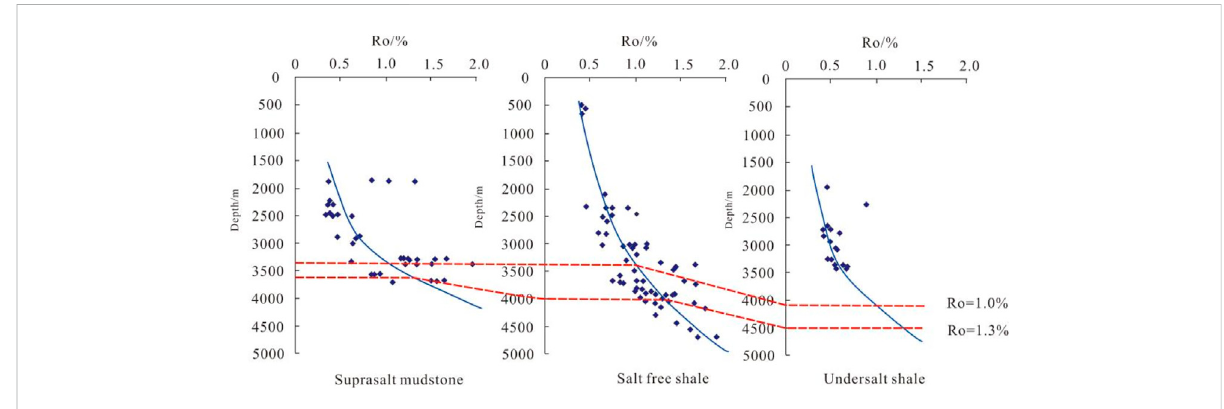
FIGURE 7 Thermal evolution characteristics for source rocks in different positions.